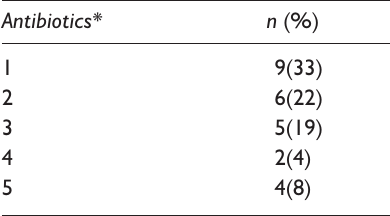
Table 5 GBS isolates that exhibited resistance to more than PNE